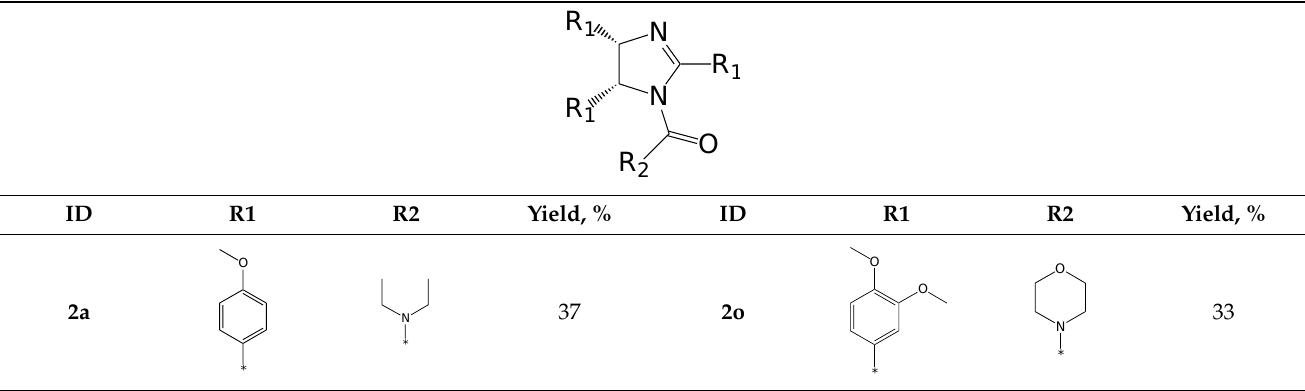
Figure 1. ( A ). The structures of novel p53-MDM2 interaction inhibitors 2l and 2k and known reference molecules Nutlin-3a (1) and RG7112 (3). ( B ). The principal synthesis approaches for nutlin derivatives. ( C ). The described approach for the synthesis of RG7112 [10]. ( D ). The developed approach. Table 1. Synthesized 2,4,5-triaryl cis-imidazoline derivatives.